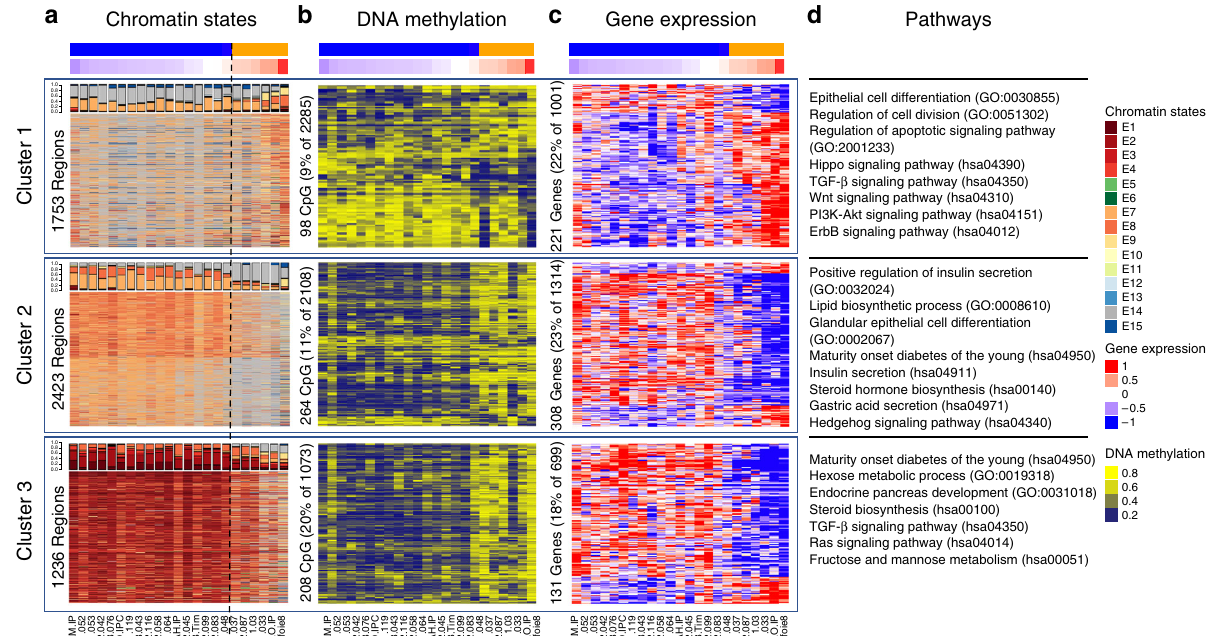
Fig. 3 Epigenomic landscapes suggest pathobiological mechanisms. a Heatmap representing chromatin states for the regions associated with the second MCA dimension has been divided into three clusters of loci with differential epigenomic landscapes. Bar plots indicating proportion of chromatin states per sample are shown on the top of each cluster, based on the color code provided in Fig. 1a. b Blue-yellow heatmap of DNA methylation for nearby CpGs located < 1 kb upstream from regions shown in relation to the MCA coordinates (mad > 0.2 and p -value < 0.05, ANOVA test). c Blue-red heatmap of gene expression for nearby genes (mainly active TSS and mainly active enhancer regions located at < 20 kb and < 100 kb upstream from TSS, respectively) shown in relation to the MCA coordinates (mad > 0.2 and p -value < 0.05, ANOVA Test). d Pathways found to be signi fi cantly altered ( p -value < 0.05, Fisher ’ s exact test) in each cluster as determined by speci fi c epigenomic landscapes. Pathway de fi nitions originate from the GO or KEGG database